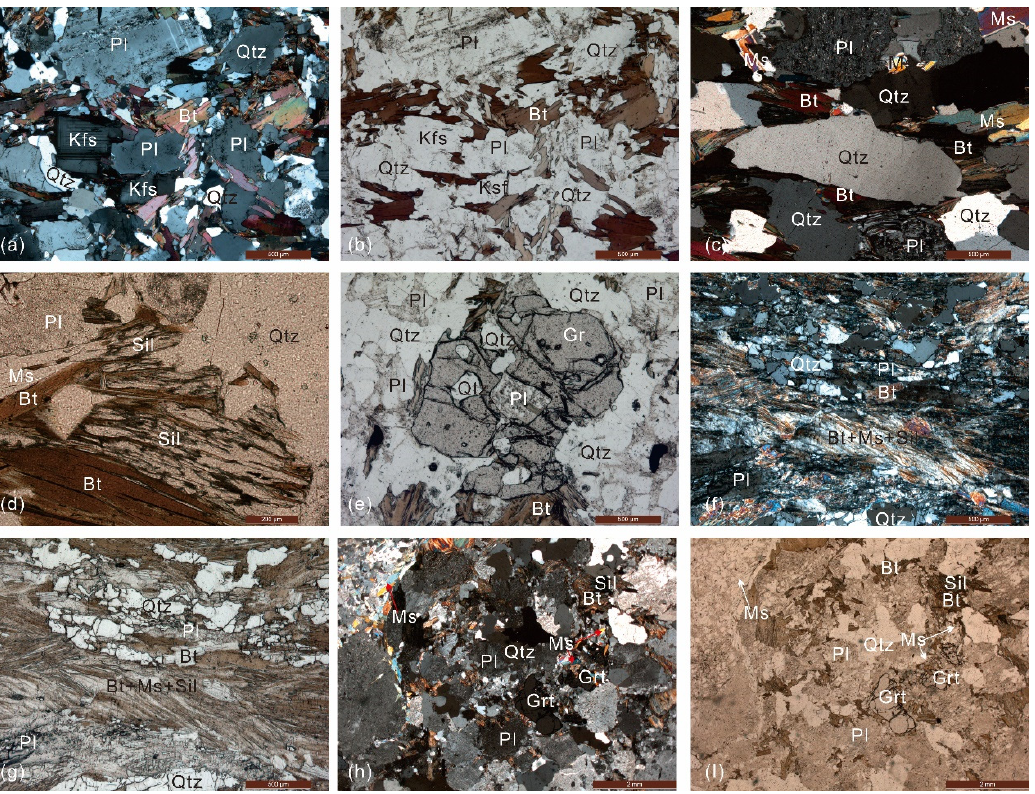
Figure 4. Microphotographs of typical textures in Paleoproterozoic rocks obtained from drill cores beneath the Ordos Basin. ( a , b ): two-mica plagioclase-gneiss (ZJ1-1); ( c , d ): sillimanite-bearing two- mica muscovite-biotite-gneiss (ZJ1-2); ( e ): granitic gneiss (Zj1-3); ( f , g ): sillimanite gneiss (ZJ1-4); ( h , i ): garnet-sillimanite-bearing two-mica gneiss (ZJ1-5).